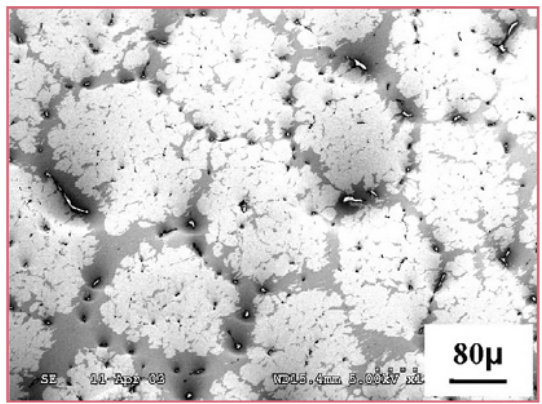
Figure 5: Cross-section of cellular rods with bright cells and dark grey cell boundaries (adapted from